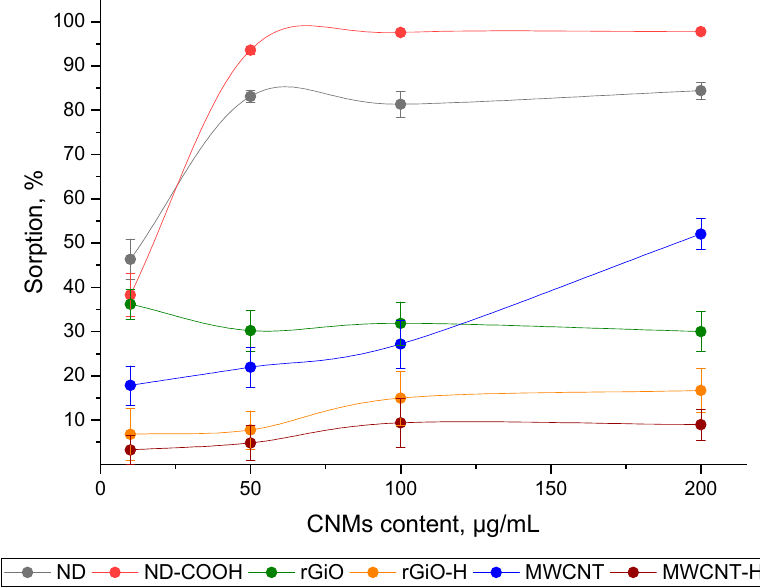
Figure 2. Sorption of 68 Ga by studied CNMs at various m / V ratios from an aqueous solution with a pH 7 at 25 °C.